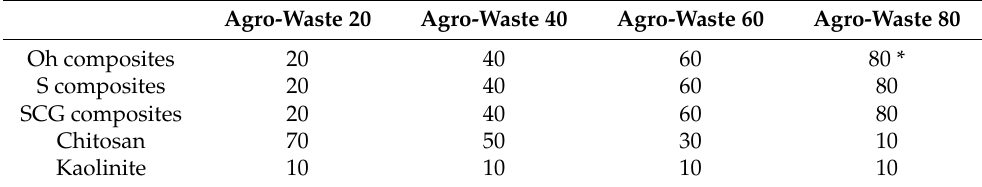
Table 2. Agro-waste biomass (oat hulls, Oh; wheat straw, S; or spent coffee ground, SCG), binder (kaolinite), and filler (chitosan) content by weight (%) for the three types of